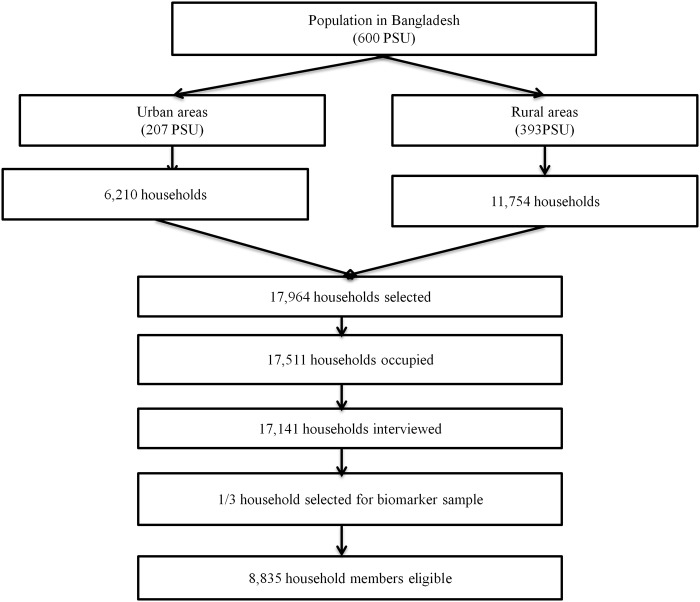
Sampling process.